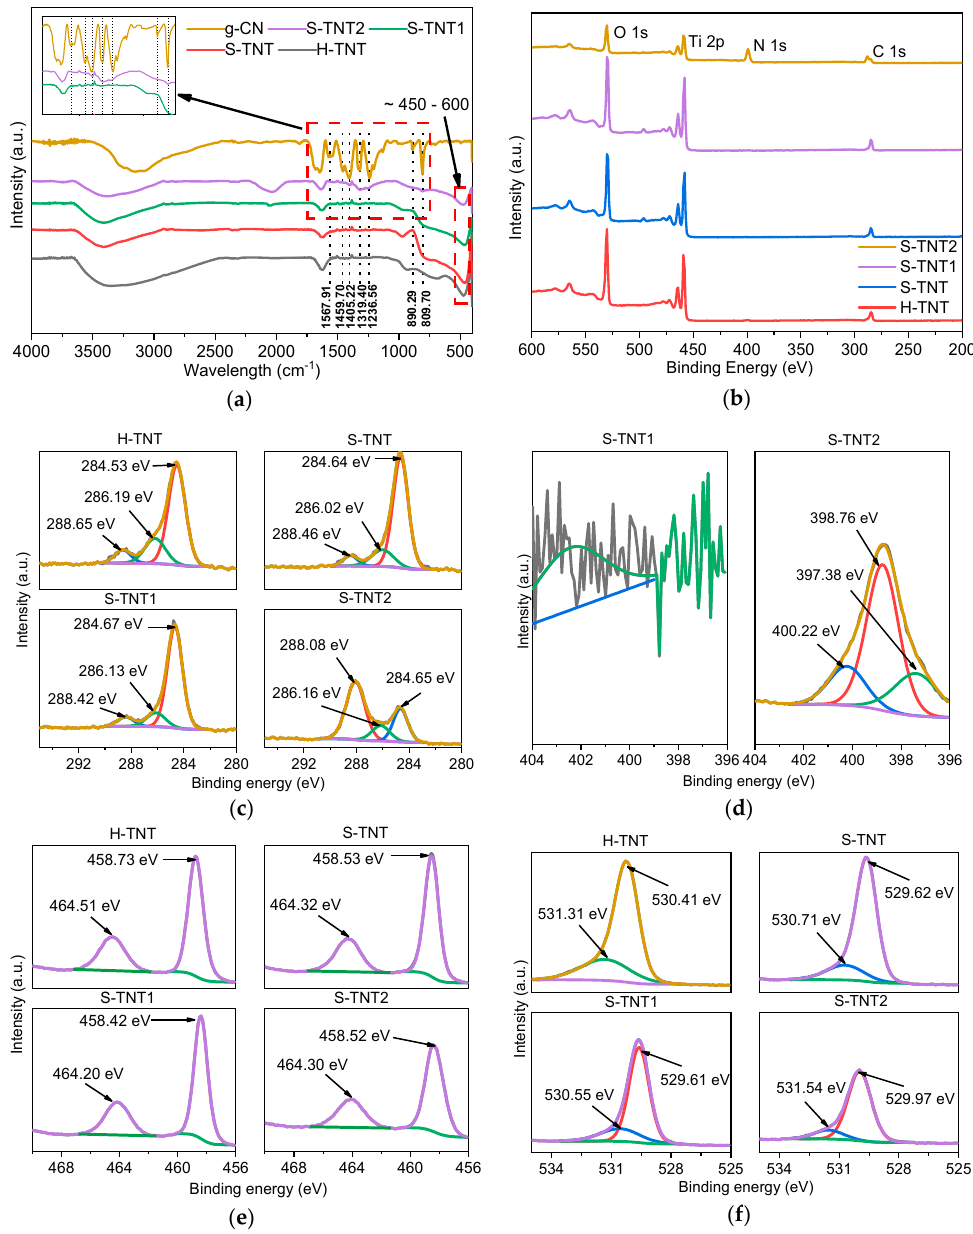
Figure 4. ( a ) Fourier transform infrared (FT-IR) spectra and ( b ) wide-angle survey scan of the as-prepared composites; high resolution survey scan of ( c ) C 1s, ( d ) N 1s, ( e ) Ti 2p, and ( f ) O 1s for H-TNT, S-TNT, S-TNT1, and